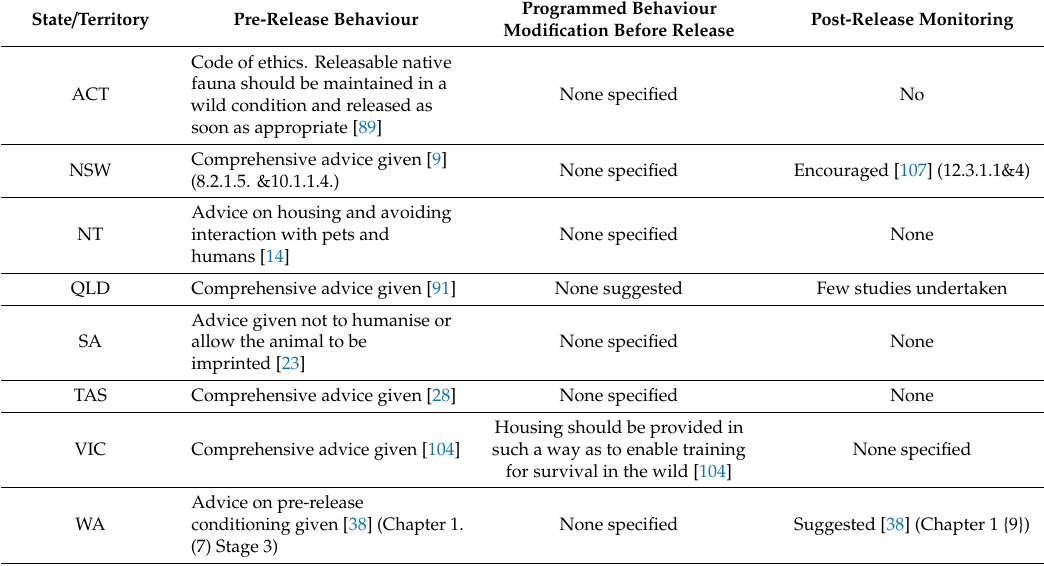
Table 9. Pre-release and post-release behaviour methodology and monitoring of native wildlife in care, as proposed in the states and territories of